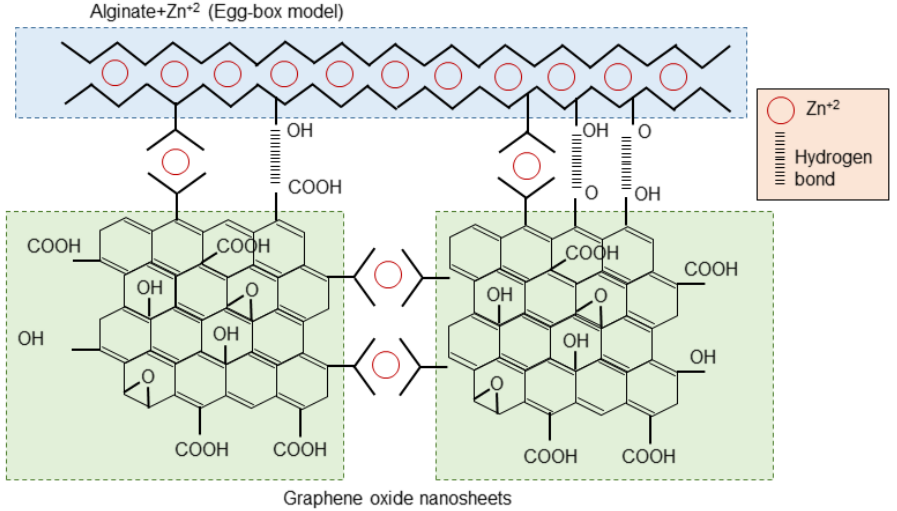
Figure 3 . Schematic model of SA/Zn/GO nanocomposite. Figure 3. Schematic model of SA / Zn / GO